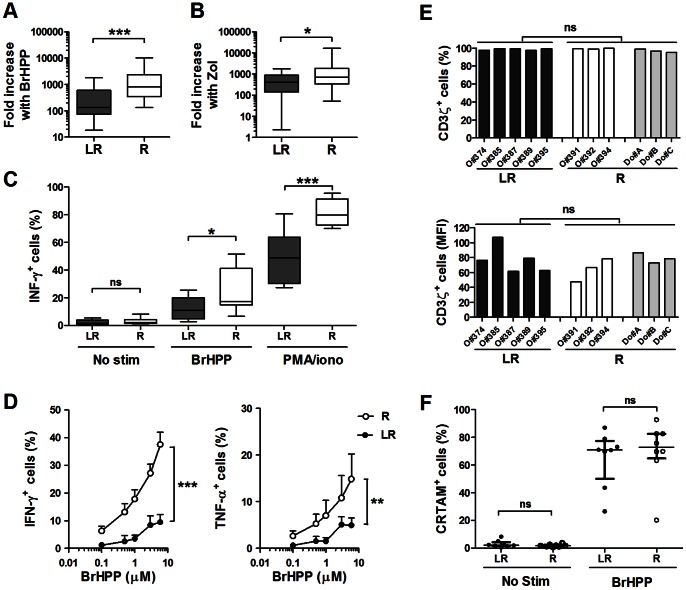
Reduced functionality of Vγ9Vδ2 cells in LR EOC PBMCs without defects in expression level of CD3ζ and CRTAM molecules.
A, B) Vδ2+CD3+ cell fold increases in LR (n = 16) and R (n = 32) EOC PBMCs at 14 days after BrHPP (A) or Zol (B) stimulation. C) Percentages of IFN-γ+ cells in the Vδ2+CD3+ cells measured at 5 h after the stimulation of ex vivo LR (n = 10) and R (n = 10) PBMCs with BrHPP (3 µM) or PMA/ionomycin (PMA/iono). D) Percentages of IFN-γ+ cells (left panel) and TNF-α+ cells (right panel) among the Vδ2+CD3+ cells measured at 5 h after stimulations of ex vivo LR (n = 4) and R (n = 4) PBMCs with increasing doses of BrHPP (0.1 to 6 µM). E) Expression of the CD3ζ chain measured on Vγ9Vδ2 PBMCs from the LR and R groups. Percentage (upper panel) and MFI (lower panel) of CD3ζ staining in the Vδ2+CD3+ cells from LR EOC PBMCs (n = 5), R EOC PBMCs (n = 3) and R donor PBMCs (n = 3). F) CRTAM expression on Vγ9Vδ2 cells measured at 20 h after stimulation of LR (n = 8) and R (n = 8) EOC PBMCs with BrHPP. No stim: no stimulation.